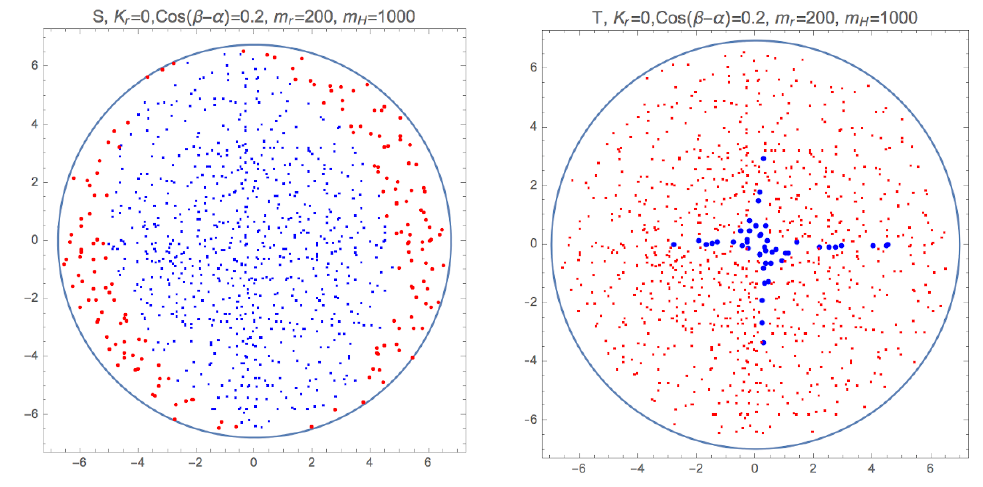
Figure 4 . Constraints on K H (y-axis) and K h (x-axis) from the S and T parameters, in the case in which one moves away from the alignment limit. The circle is the theoretically allowed region, the blue dots are allowed by the S and T parameter bounds, and the red dots are disallowed. The other parameters chosen are listed at the top of the (cid:12)gures with m A = 500 GeV, (cid:3) = 5